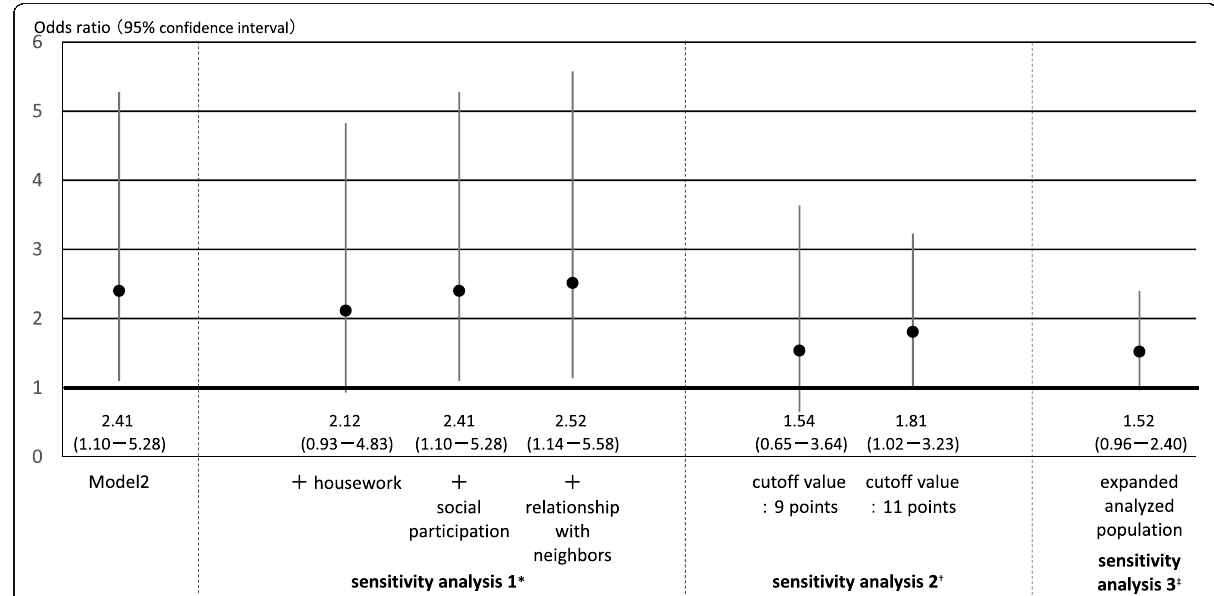
Fig. 3 Three sensitivity analyses based on Model 2 in those living with child and his/her spouse among women. *Results when each covariate of activities inside and outside the home was added separately. † Results when the cutoff value was changed from 10 points on the TMIG-IC to 9 points and 11 points, respectively. ‡ Result when the analyzed population was expanded from those who scored 13 points on the TMIG-IC to those who scored 11 points or more ( n = 2173) with adding baseline scores to covariates